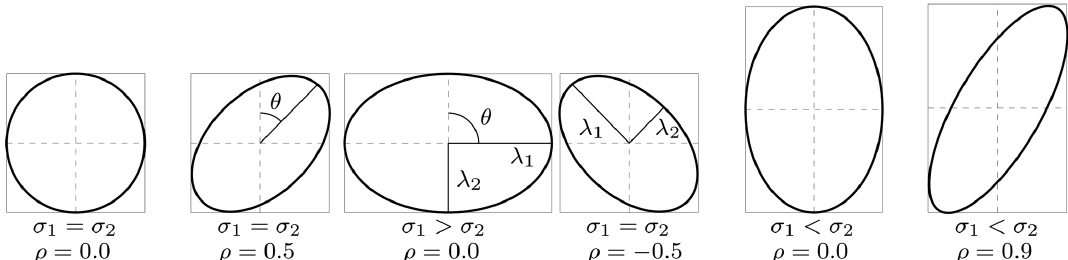
Figure B1. Example of ellipses with different dispersion parameters. Illustration adopted from Polman and Salzmann (1996).